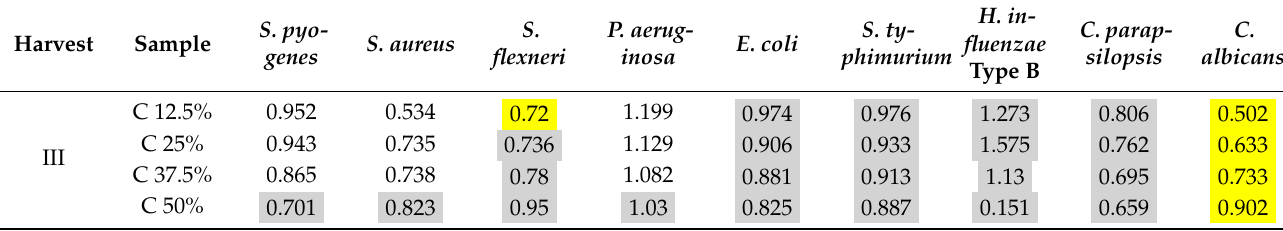
Table 4. OD value (540 nm) for honey samples after treatment with EOs (Harvest